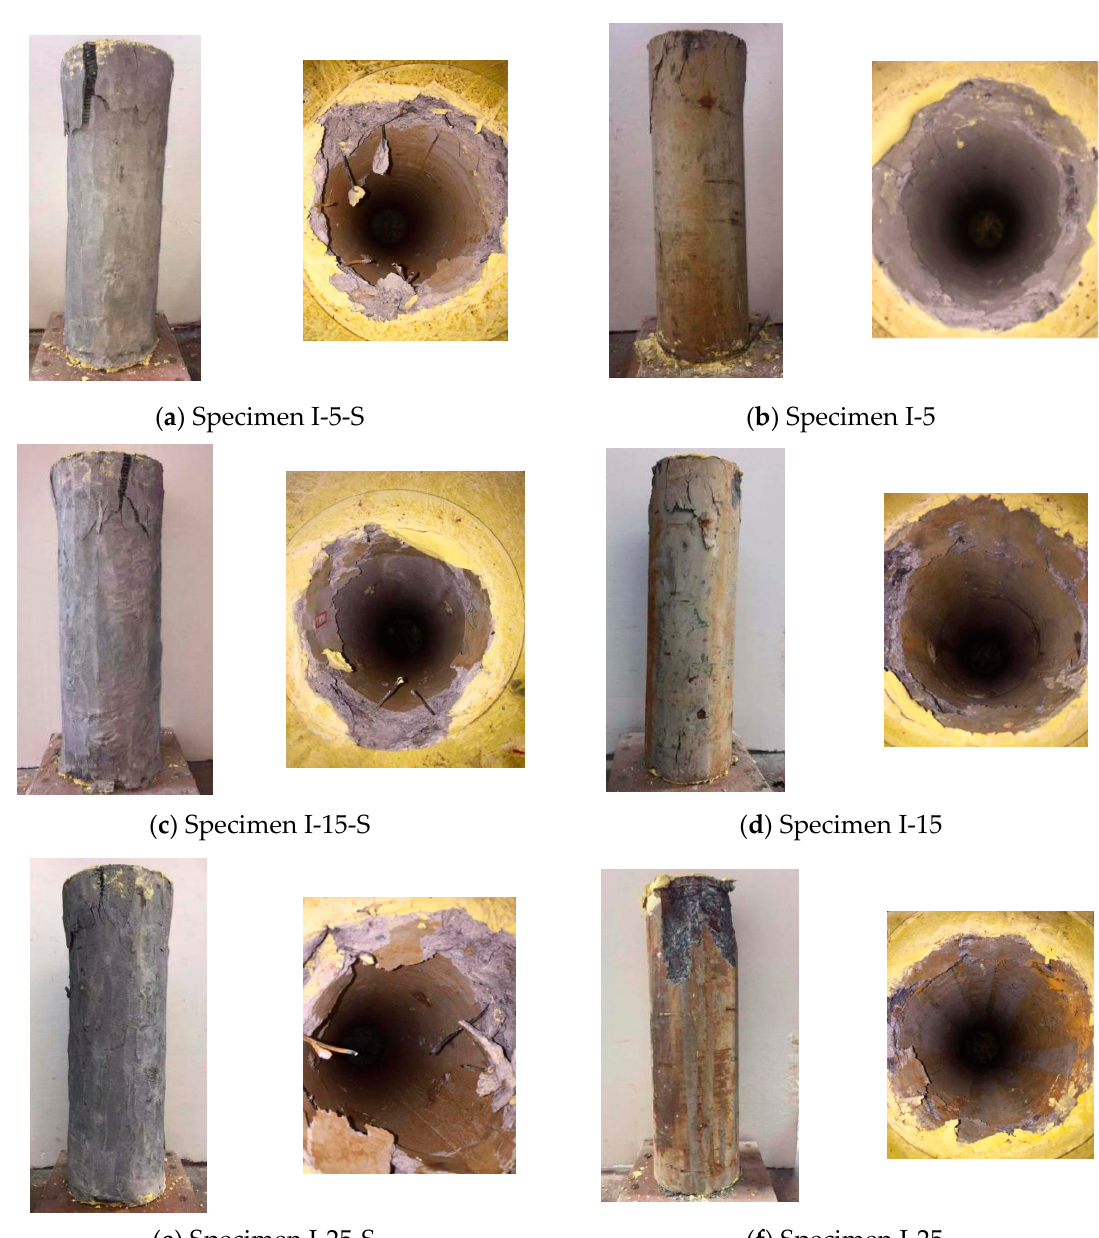
Figure 7. Failure modes of the axial compression specimens.